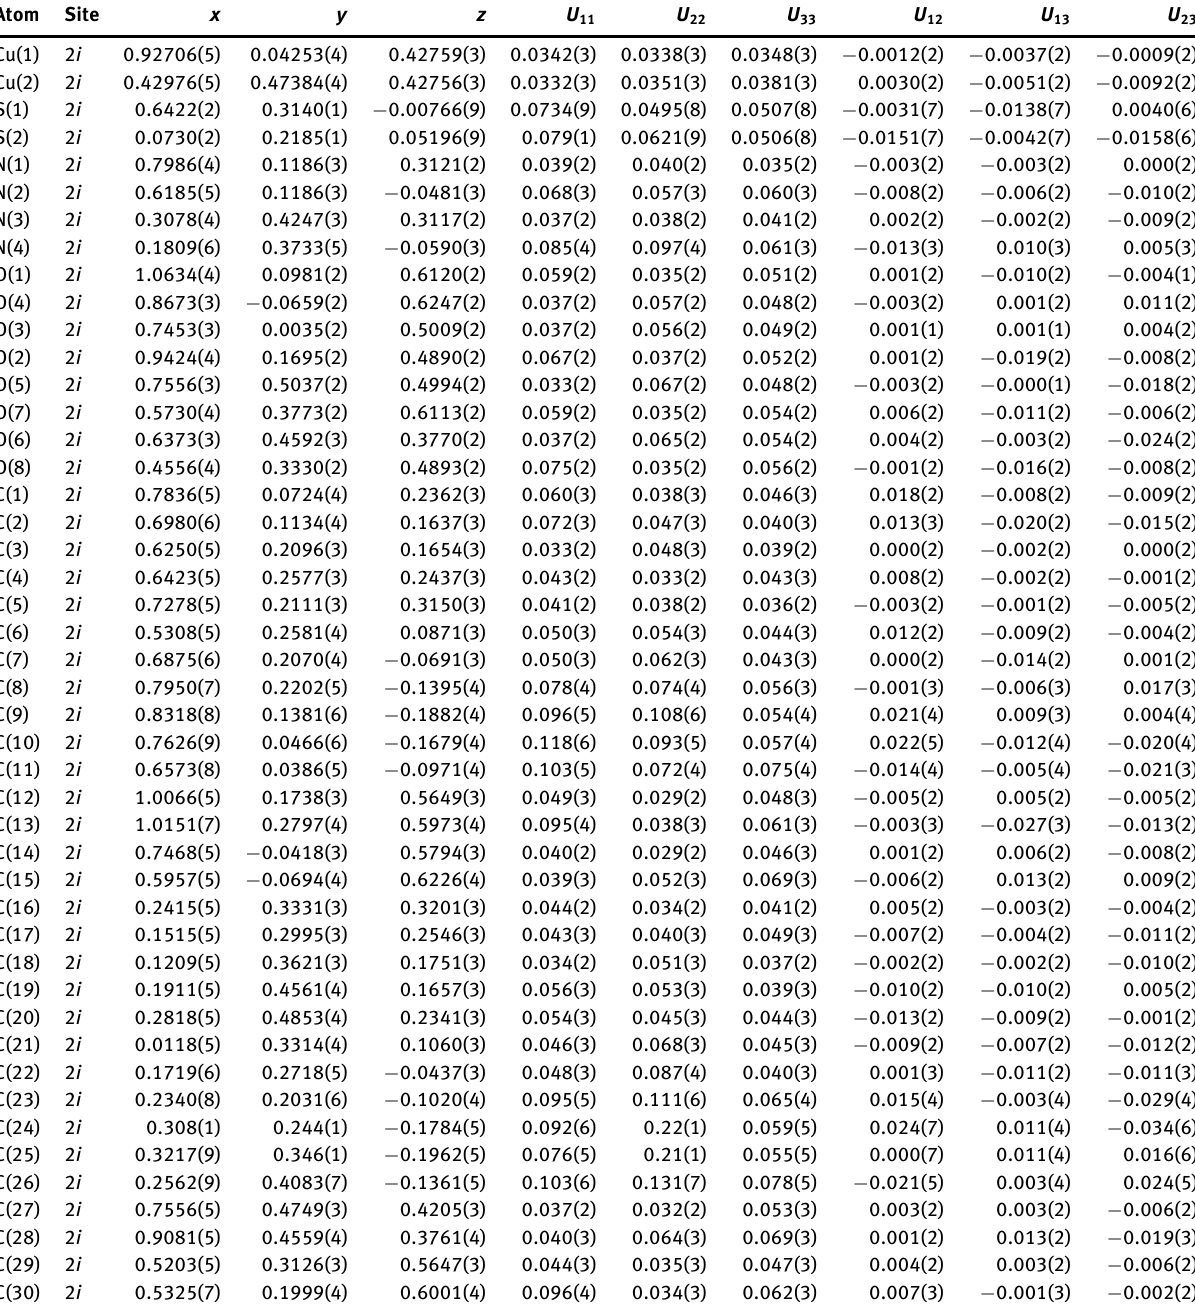
Table 3: Fractional coordinates and atomic displacement parameters (Å 2